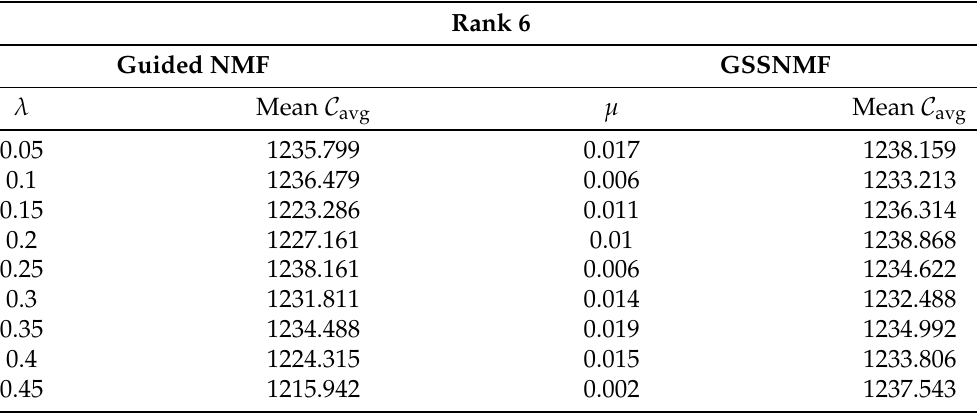
Table A1. Mean of averaged coherence scores from 10 independent trials (mean NMF and GSSNMF given λ and the best-performing µ for each λ , by